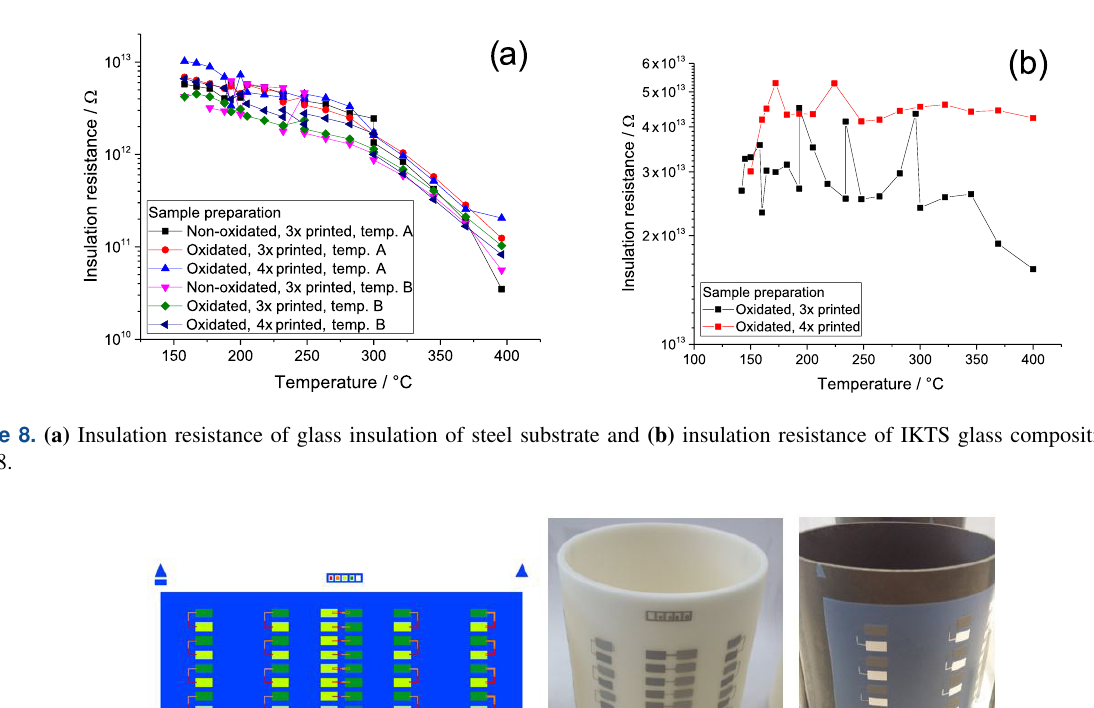
wire interconnection to connect to two temperature measure- ment cards from National Instruments with 16 channels